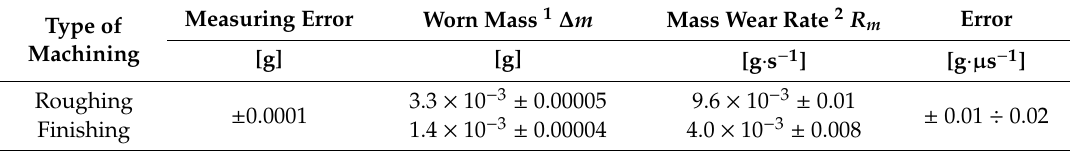
Table 7. Mass wear rate of electrical discharge machining of 12Kh18N10T (AISI 321) steel. Type